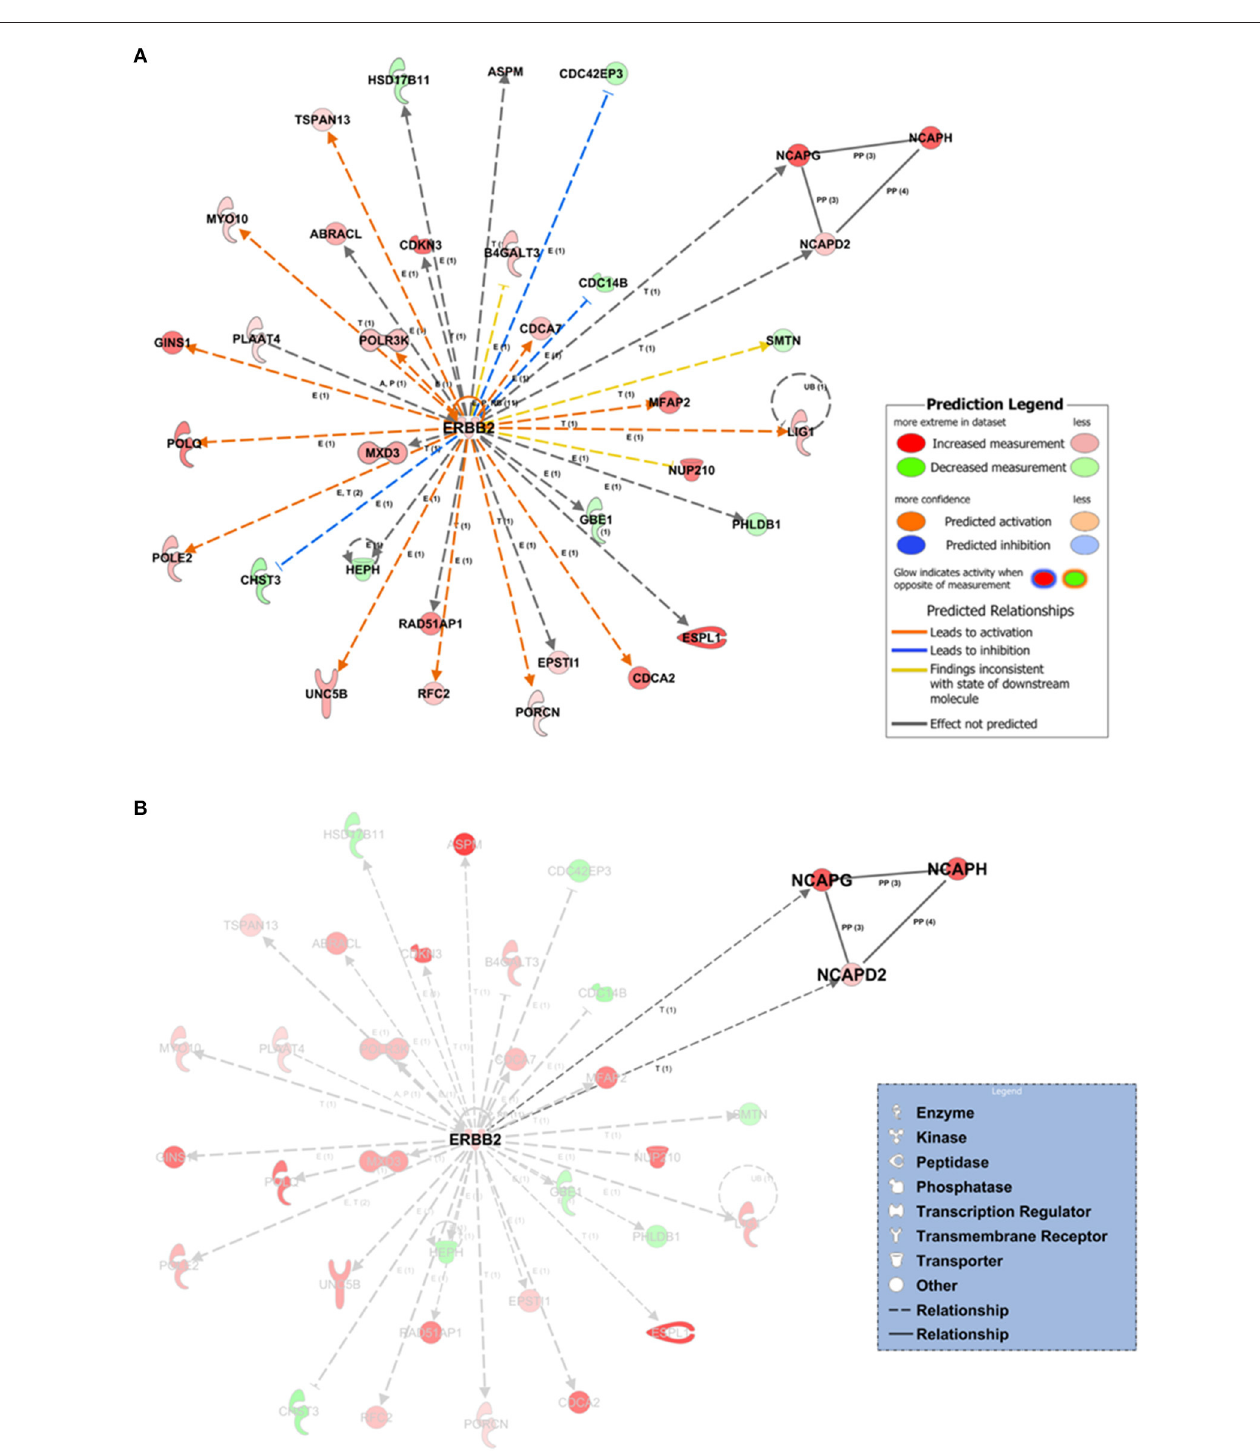
FIGURE 4 | Network inference underlying the 1,642 tumor-associated genes. (A) The top-scoring network (the first over 25 networks) based on the statistical approach and manually curated IPA Knowledge Base (IPA KB). Network edges associated with ERBB2 direct (continuous lines) or indirect relationships (dashed lines) at expression, transcription, or protein–protein-binding level. In silico prediction of the ERBB2 downstream impact within the network is highlighted by orange-pointed arrowheads (activation effect) or blue blunt arrowheads (inhibitory effect) based on the expression changes and the experimentally observed evidences within the IPA KB. (B) Protein–protein interaction subnetwork within network 1 formed by the non-SMC condensin I complexes (NCAPD2, NCAPG, NCAPH). E, expression; T, transcription; P, phosphorylation/dephosphorylation; PP, protein–protein interaction (binding).